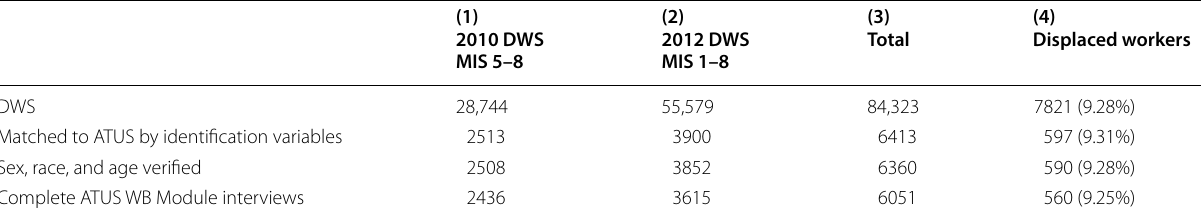
Table 8 Number of Matched Individuals between the DWS and the ATUS WB Modules and the Final Sample Size